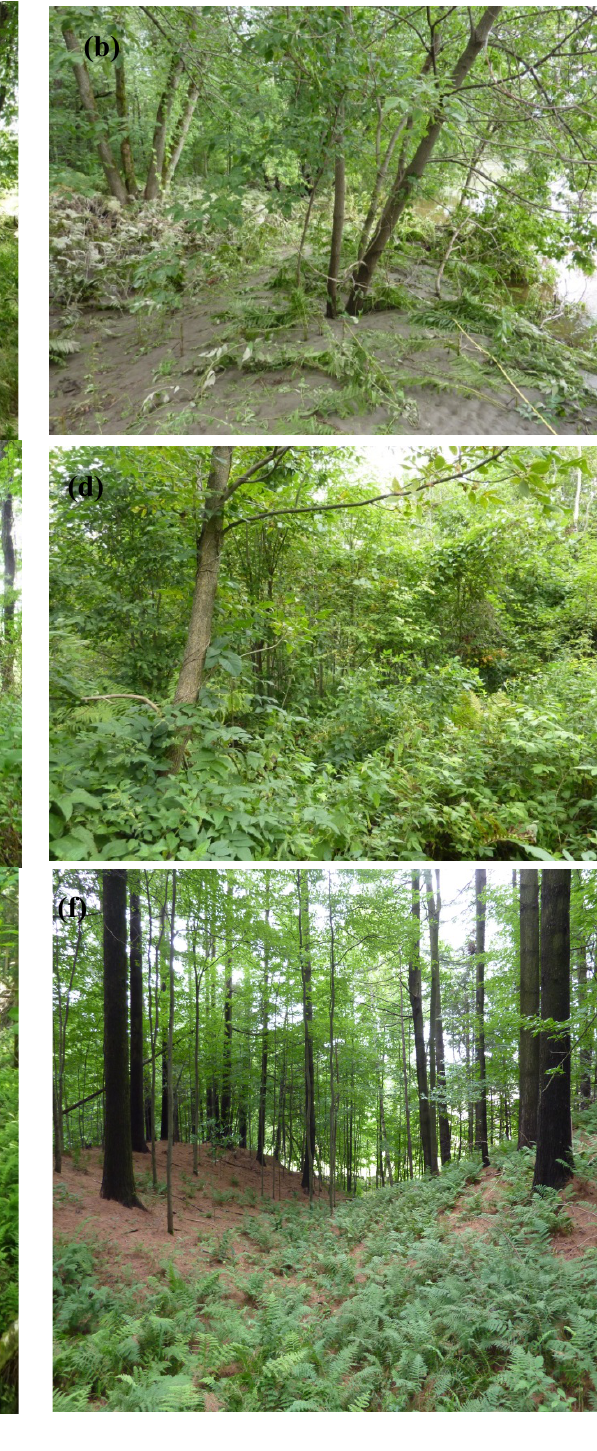
Figure 4. Photographs of tree stands in different flood risk zones and in no-flood zones in the two sectors (MAS and STF); ( a ) Typical tree stand on active floodplain (Richmond sector). In the zone with frequent flood recurrence (interval of 0–20 years), the old trees are often dominant and the stands are characterized by a very low regeneration rate; ( b ) Riparian trees affected by summer flood (August 30, 2011 (Richmond sector); ( c ) Young forests located in intermediate flood zones (interval of 20–100 years) (MAS sector); ( d ) Typical tree stand in intermediate zone (STF sector); ( e ) Tree stands in uplands located along the Massawippi and ( f ) Saint-François rivers (Windsor